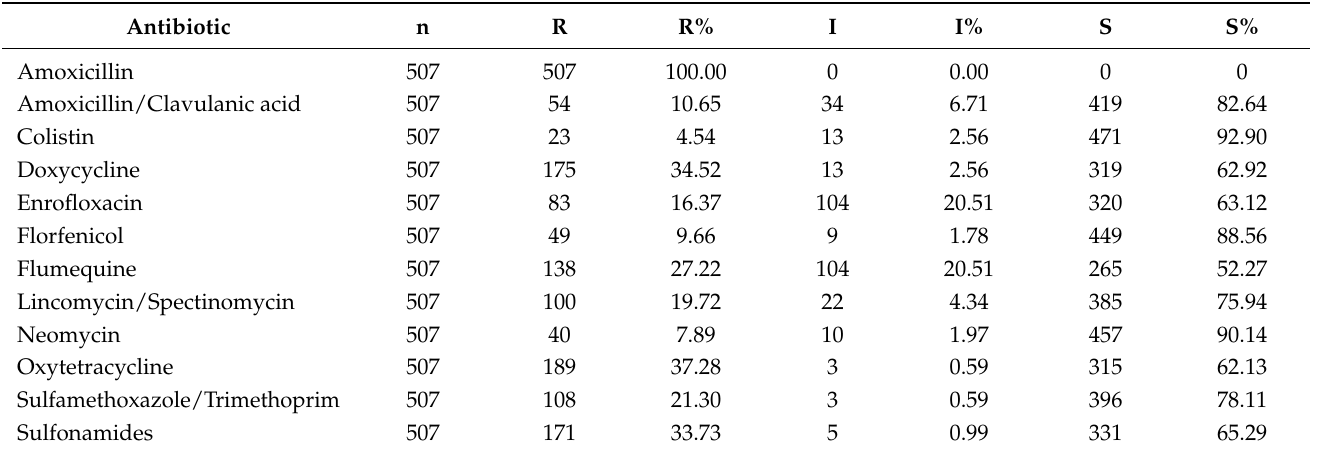
Table 1. Antibiotic susceptibility of Klebsiella spp. strains (n = 507) isolated from turkeys between 2019 and 2022.